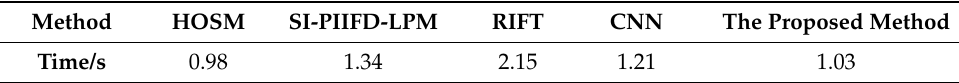
Table 2. Average computational efficiency comparison of five